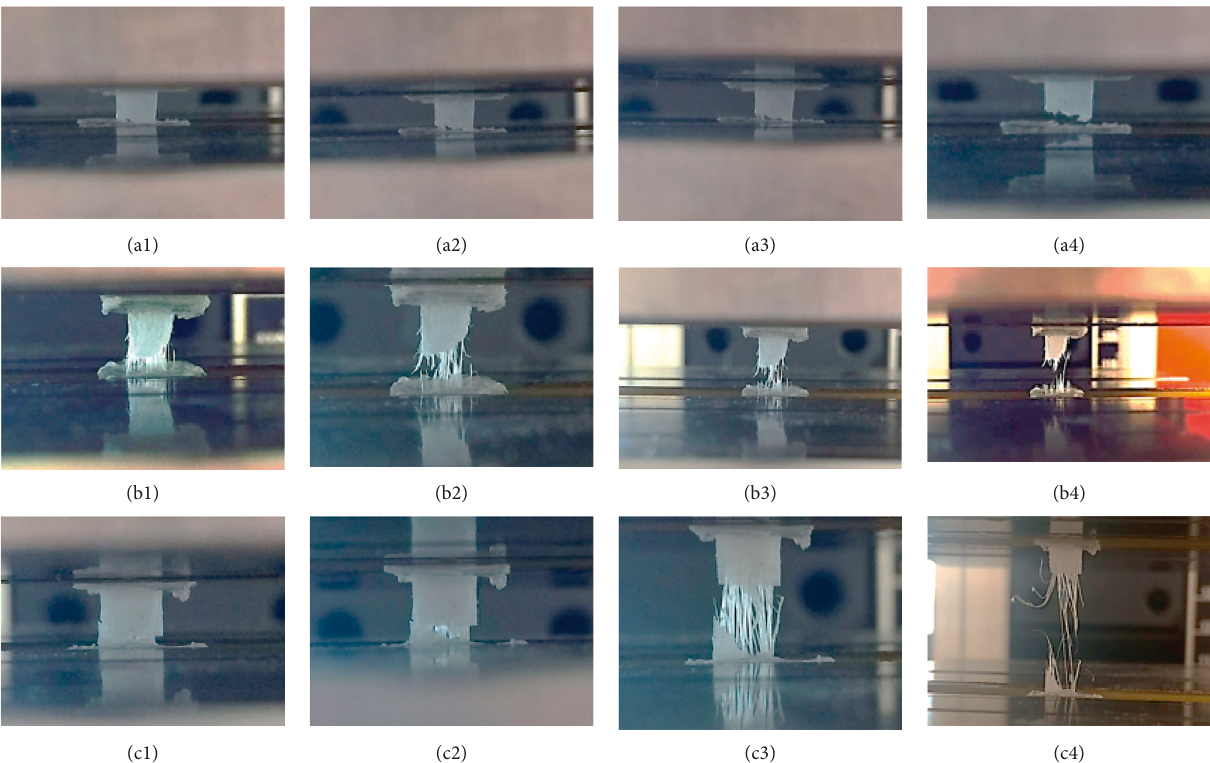
Figure 4: Various stages of tensile deformation of polycaprolactone (PCL) samples. (a1–a4) Bulk PCL. (b1–b4) Unidirectionally oriented PCL sample, composed of fibres aligned along the loading axis. (c1–c4) Helicoidal PCL sample, composed of fibres aligned at different angles forming helicoidal structure.